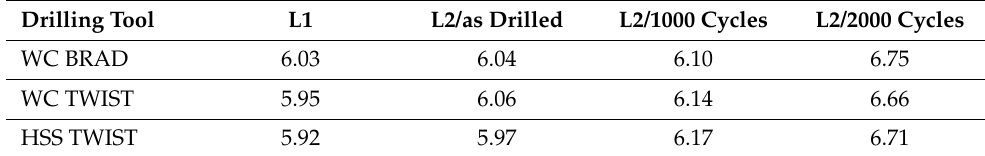
Table 5. Ovality of drilled holes after bearing cycles ASTM D-6873 (values in mm). Drilling Tool